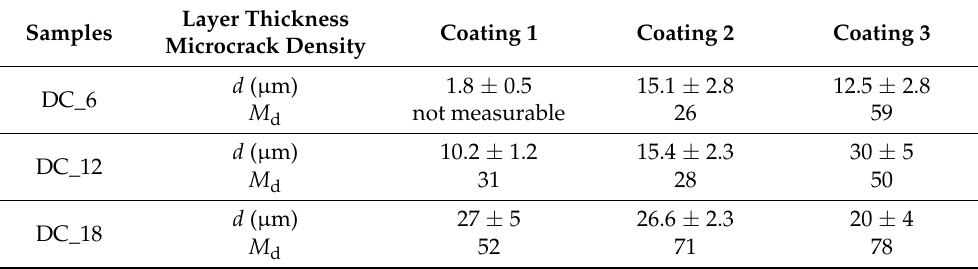
Table 3. Layer thicknesses d and microcrack density M d (counted number of cracks per 1000 µ m) of DC coatings determined by optical microscopy.